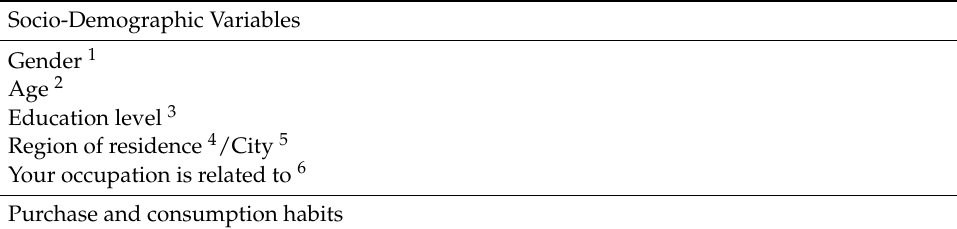
Table A1. Questionnaire on consumer socio-demographic characteristics, purchase and consumption habits, beliefs and choice